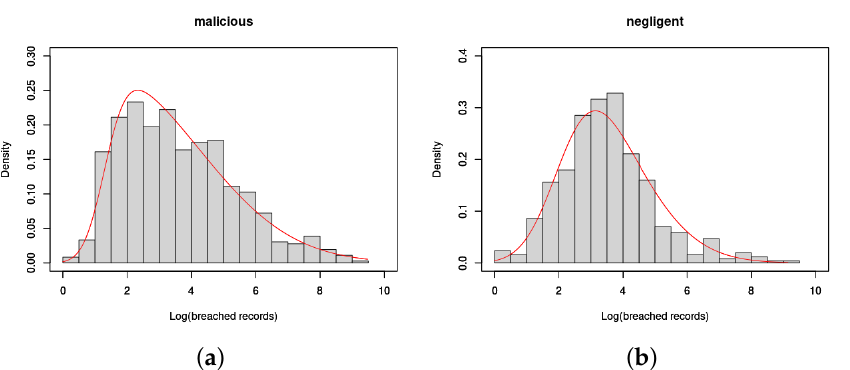
Figure 3. Empirical (histograms) vs. estimated (red line) distributions of the severity of breaches, measured by the number of breached records for ( a ) malicious and ( b ) negligent breach types, respectively. Data for all but MED type companies as reported in the PRC dataset in the time period